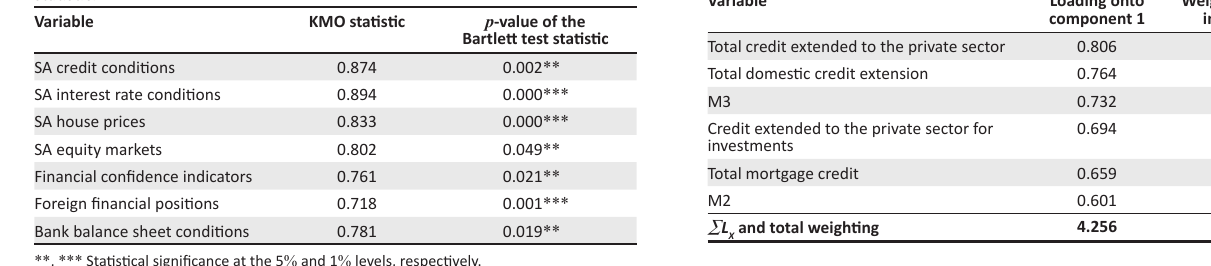
TABLE 3: Component loadings of South African interest rate conditions.